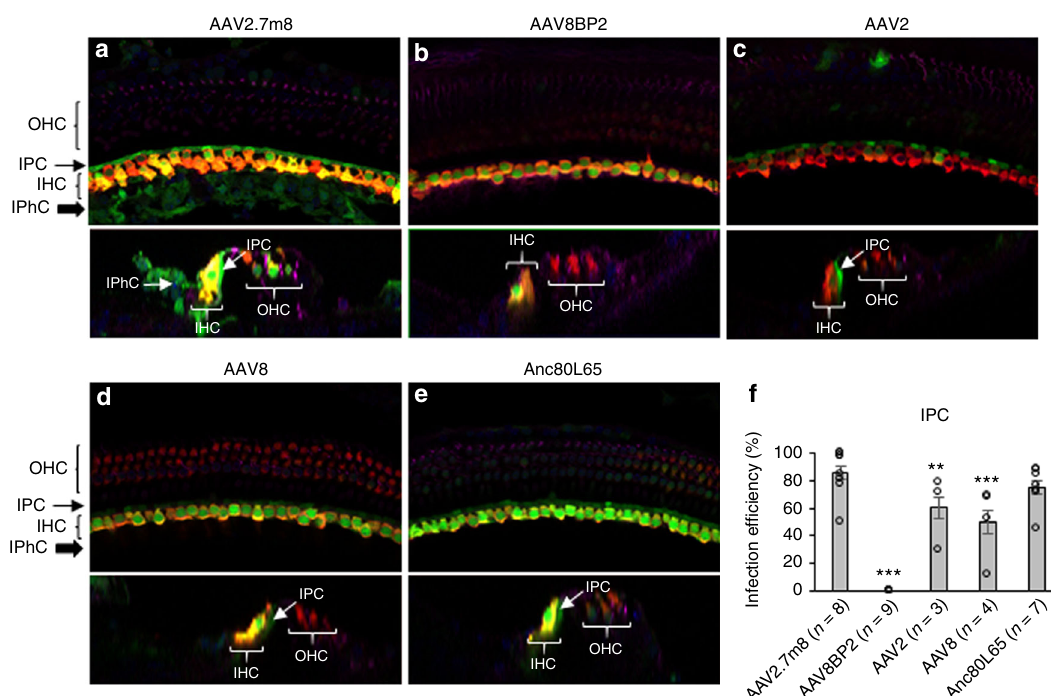
Fig. 4 AAV2.7m8 infects inner pillar cells and inner phalangeal cells with high ef fi ciency. a – e Confocal images of cochlear apex showing inner pillar